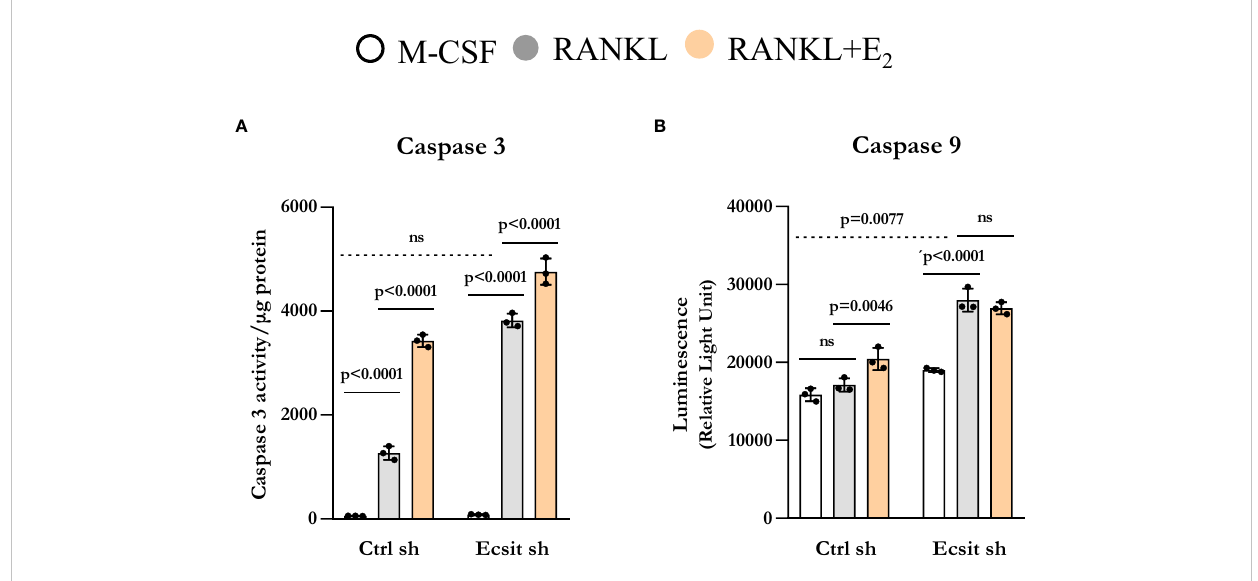
FIGURE 5 Knockdown of ECSIT promotes apoptosis of osteoclast progenitors. BMMs were silenced Ecsit sh (#2) or control (Ctrl) sh lentivirus particles. All assays were performed in cells cultured as indicated for 24 h. (A) Caspase-3 and (B) Caspase-9 activity normalized for protein content. Bar graphs depict mean ± S.D. of 3 wells (black dots) of one representative experiment; p values analyzed by 2-way ANOVA. ns=not signi fi cant (p>0.05).